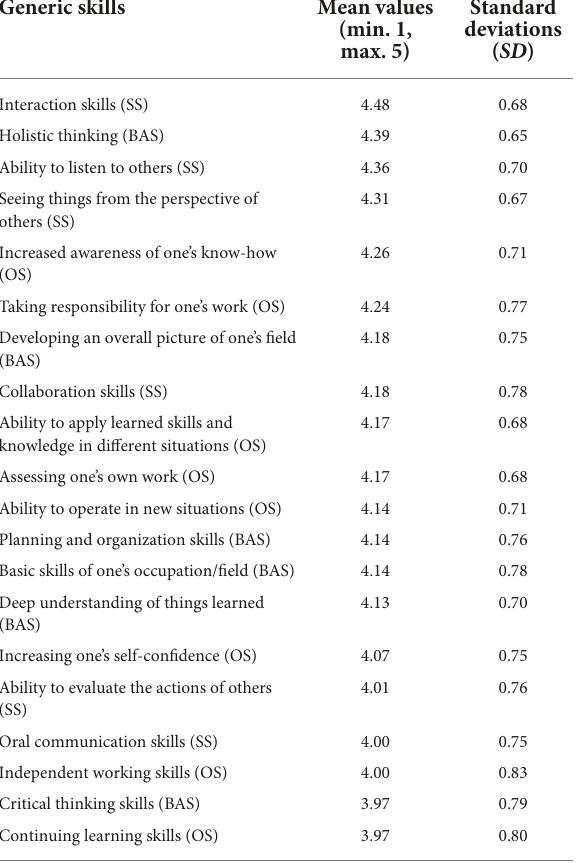
TABLE 3 Mean values of variables describing perceived learning of generic skills among PE students during their final year study module ( n =